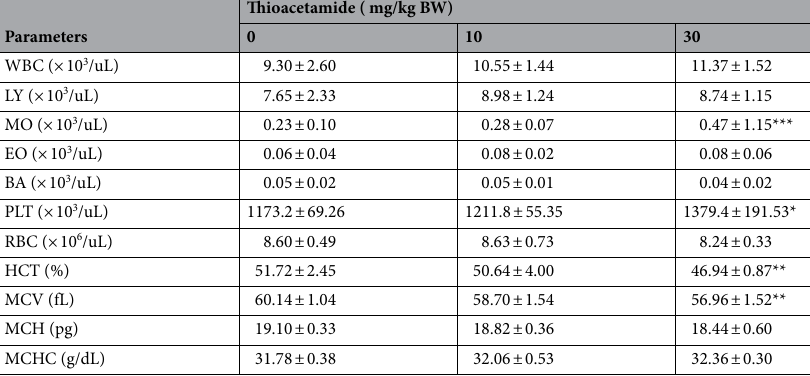
Table 2. Hematological values of rats exposed to TAA. WBC white blood cells, LY lymphocytes, MO monocytes, EO eosinophils, BA basophils, PLT platelets, RBC red blood cells, HCT hematocrit,